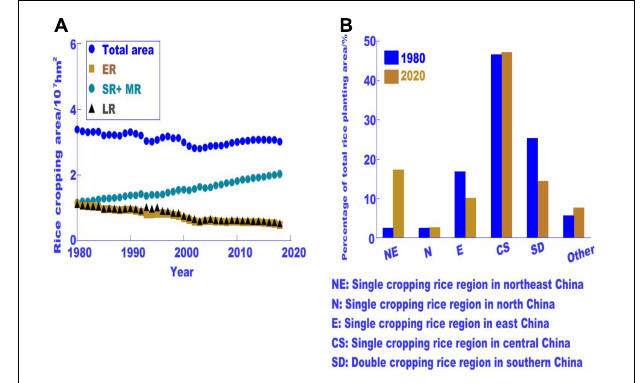
FIGURE 3 | Changes in rice planting area in China over the past 40 years. (A) Changes in rice planting area in different rice cropping types; (B) differences in the percentage of rice planting area in the total rice area of China in different rice growing regions (modified from Lv et al.,